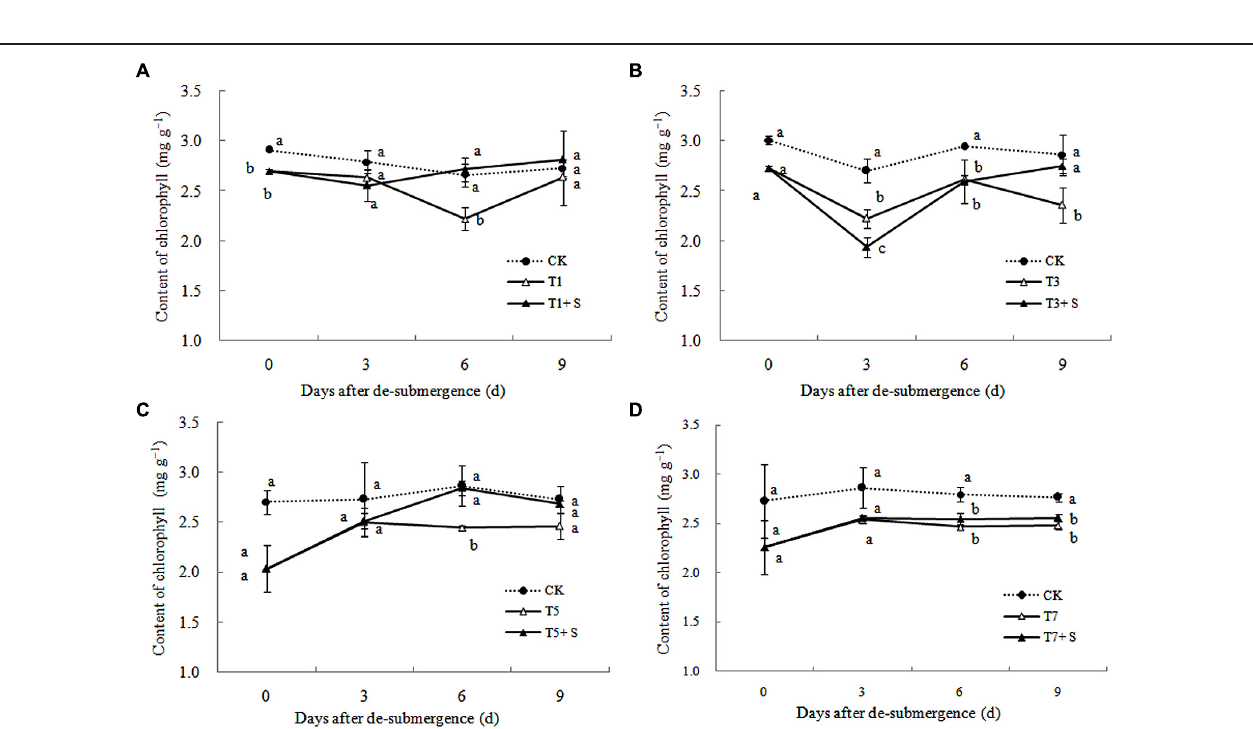
FIGURE 5 | Effects of Spd on yield traits of rice after submergence. Each data point in the spider plots represents the percentage of the mean values of the agronomic traits. The mean measurements from the CK were assigned a 100% reference value.